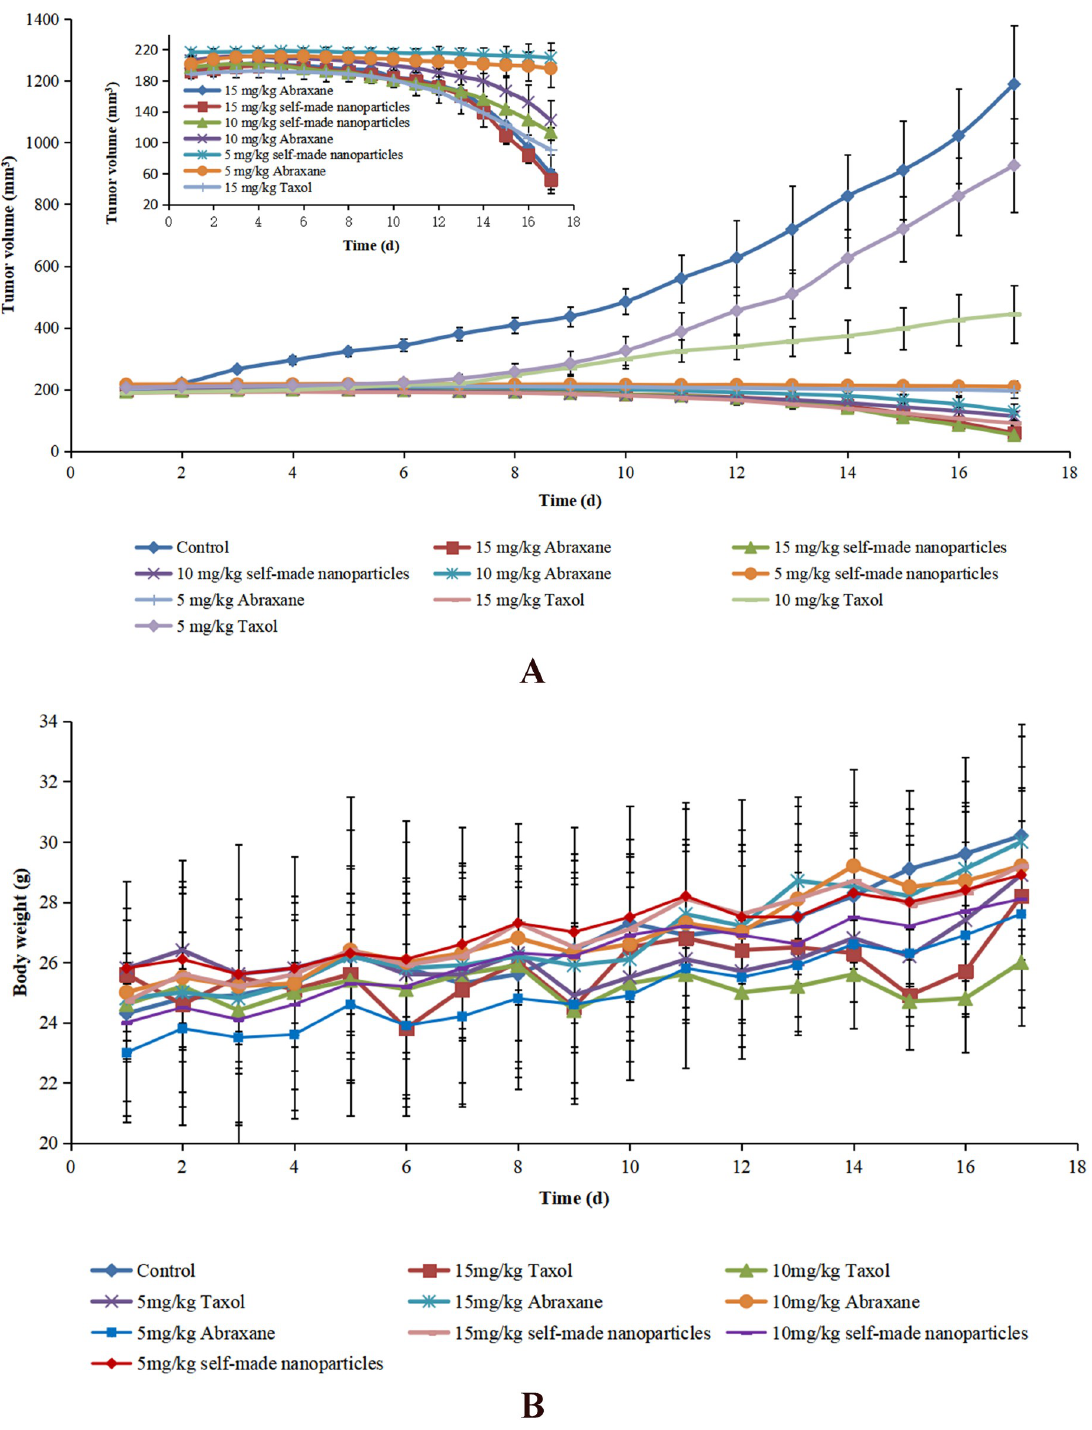
Fig 9. Anti-tumor effects of different paclitaxel formulations after intravenous administration to H22 tumor-bearing mice. (A) Anti-tumor efficacy in H22 tumor-bearing mice after treatment with Taxol, Abraxane, and self-made nanoparticles at different doses (5mg/kg, 10mg/kg and 15mg/kg). (B) Body weight changes of H22 tumor-bearing mice after treatment with Taxol, Abraxane, and self- made nanoparticles at different doses (5mg/kg, 10mg/kg and 15mg/kg). Data are presented as means ± SD (n = 5).